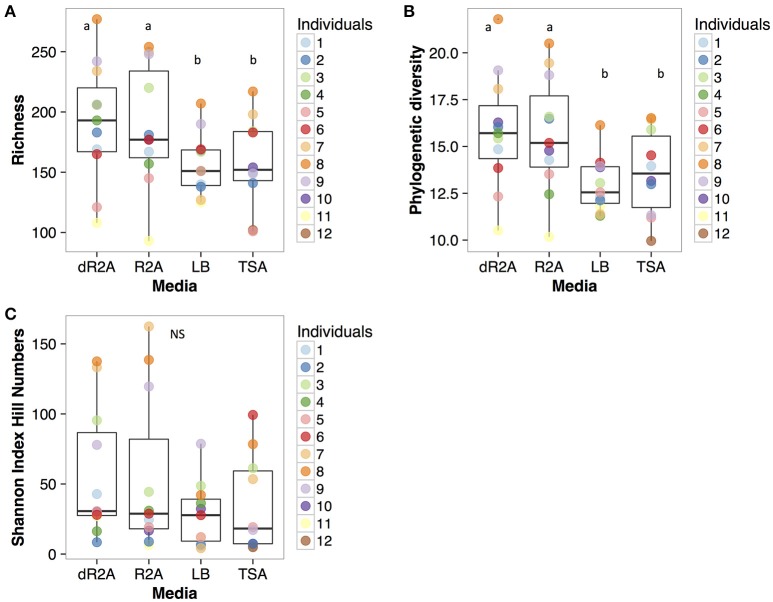
Alpha diversity estimates for the different metrics ((A): OTU richness; (B): Faith's phylogenetic diversity; (C): Shannon Index) by culture media type. Alpha diversity estimates are color-coded at the toad (individual #). Boxplots represent the median, upper and lower quartile, and maximum and minimum values.